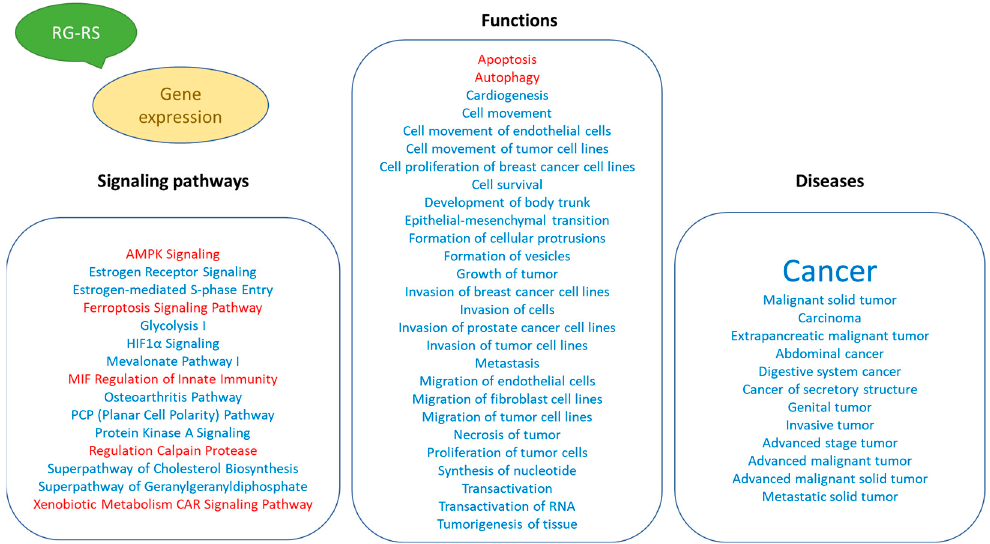
Figure 5. Potential effects of RG–RS on diseases and disorders, biological processes, cellular and physiological function, and detected impact on intracellular signaling and metabolic pathways.